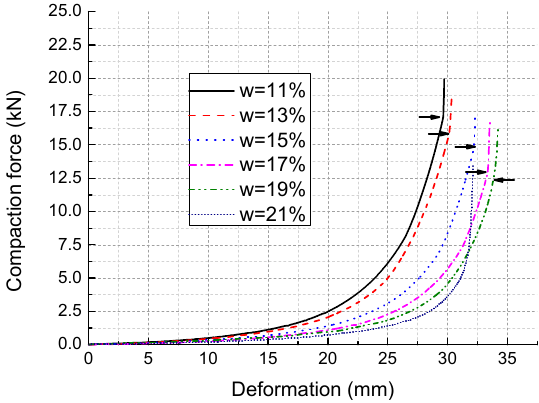
Figure 7. Typical compaction curves.